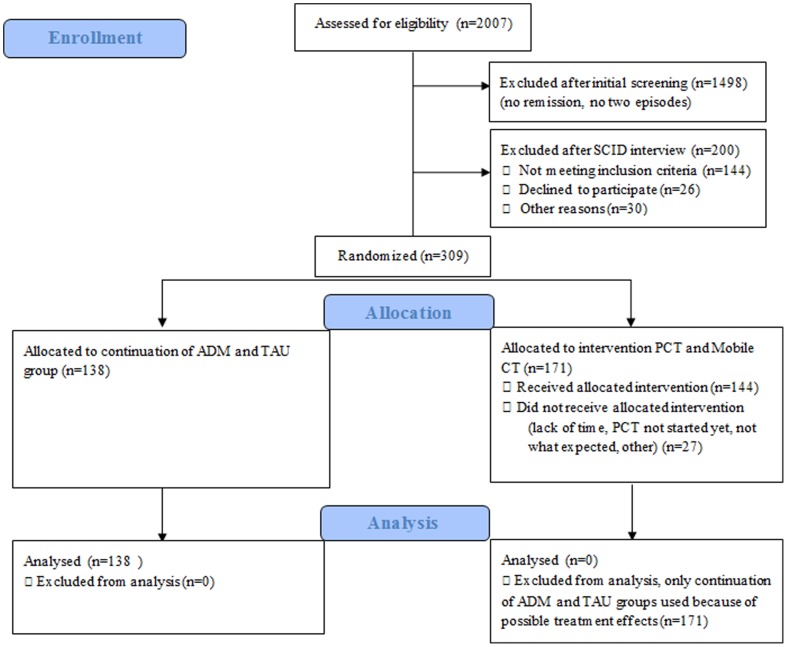
Consort Flow Diagram of participant flow.